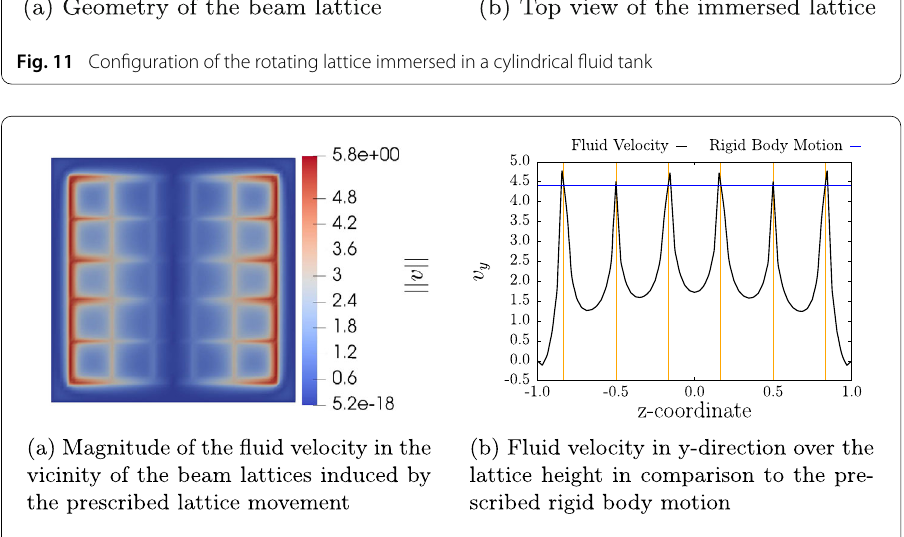
Fig. 12 Fluid velocity profile induced by the moving beam lattice along the height of the fluid cylinder